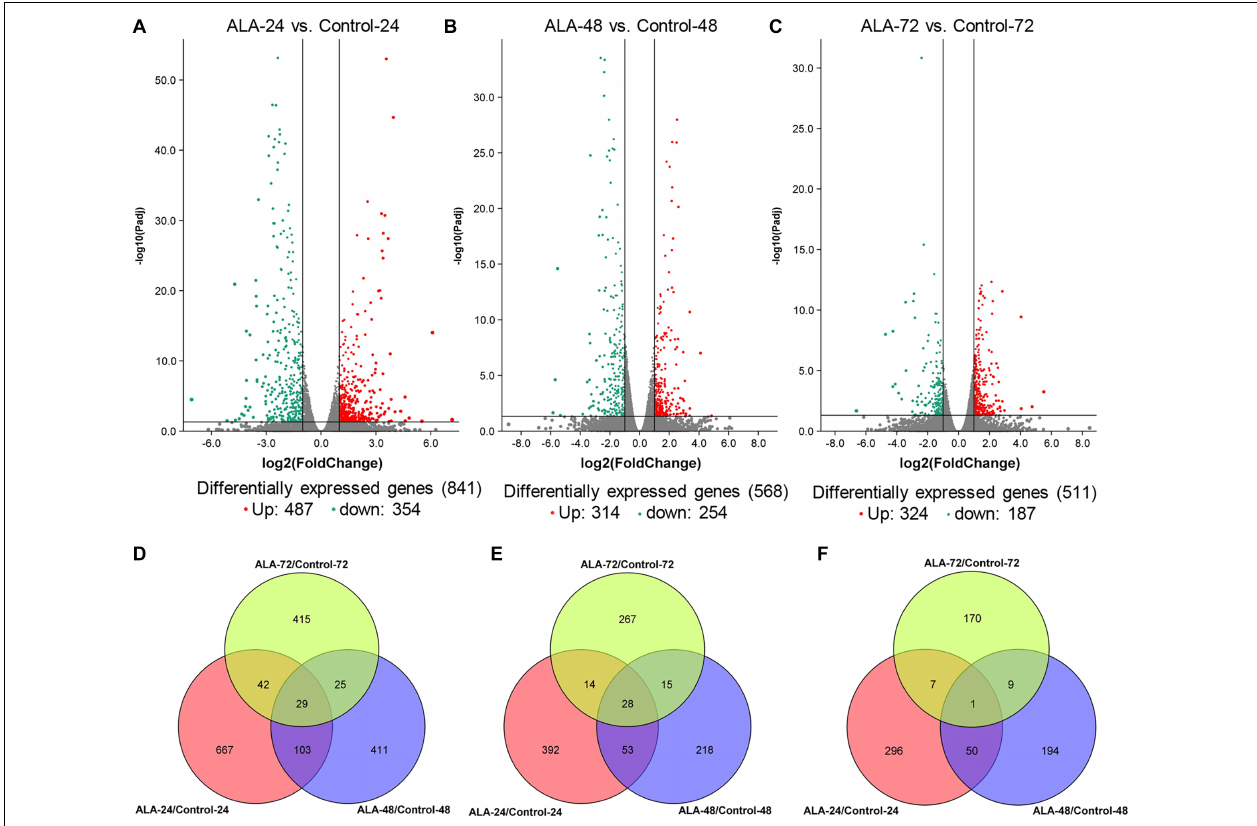
FIGURE 2 | Differentially expressed genes (DEGs) identified by RNA-seq analysis in ALA-treated and control calli after illuminating for 24, 48, and 72 h. (A–C) Volcano plot of the RNA-seq showing DEGs in red and green. The X -axis represents the fold change in ALA-24 versus Control-24, ALA-48 versus Control-48, and ALA-72 versus Control-72, respectively. The Y -axis represents the negative –log 10 -transformed p values ( p-adj < 0.05) for differences between the samples. (D) Quantity of total DEGs. (E) Quantity of up-regulated DEGs. (F) Quantity of down-regulated DEGs. Overlapping areas shows the shared DEGs at different time points.